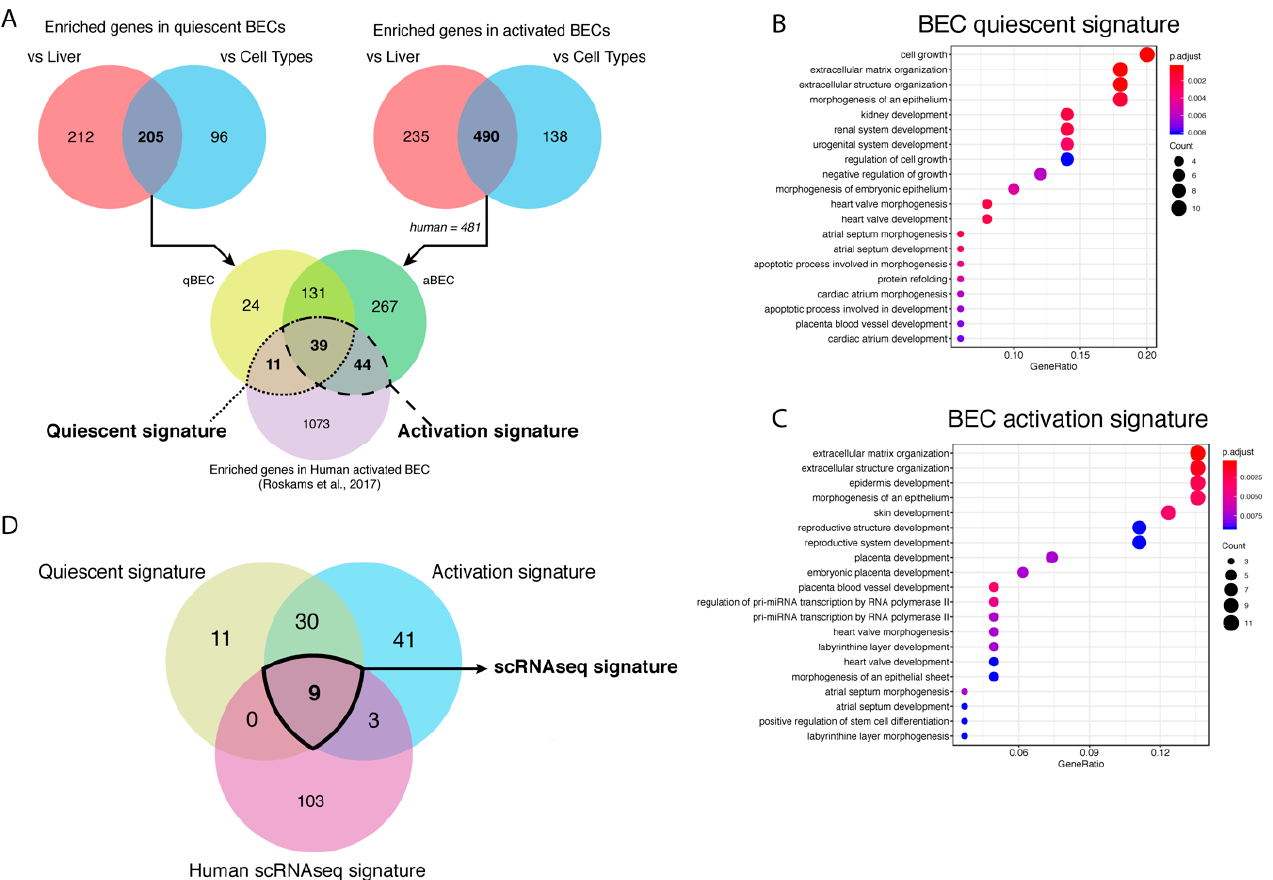
Figure 5. Generation of BEC gene signatures. ( A ) Venn diagrams of the genes enriched in BECs compared to healthy livers or different cell types and both merged gene sets compared to genes enriched in human BECs. Gene ontology (GO) analysis of quiescent ( B ) and activated ( C ) BEC gene signature. The size of the circle is correlated to the number of genes involved in that GO. The color of the circle represents significance (adjusted p -value) and the x -axis stands for gene ratio (genes within signature versus total number of genes in GO). ( D ) Venn diagram of genes enriched in quiescent and activated BECs (microarray / RNAseq) and in BECs from scRNAseq of human